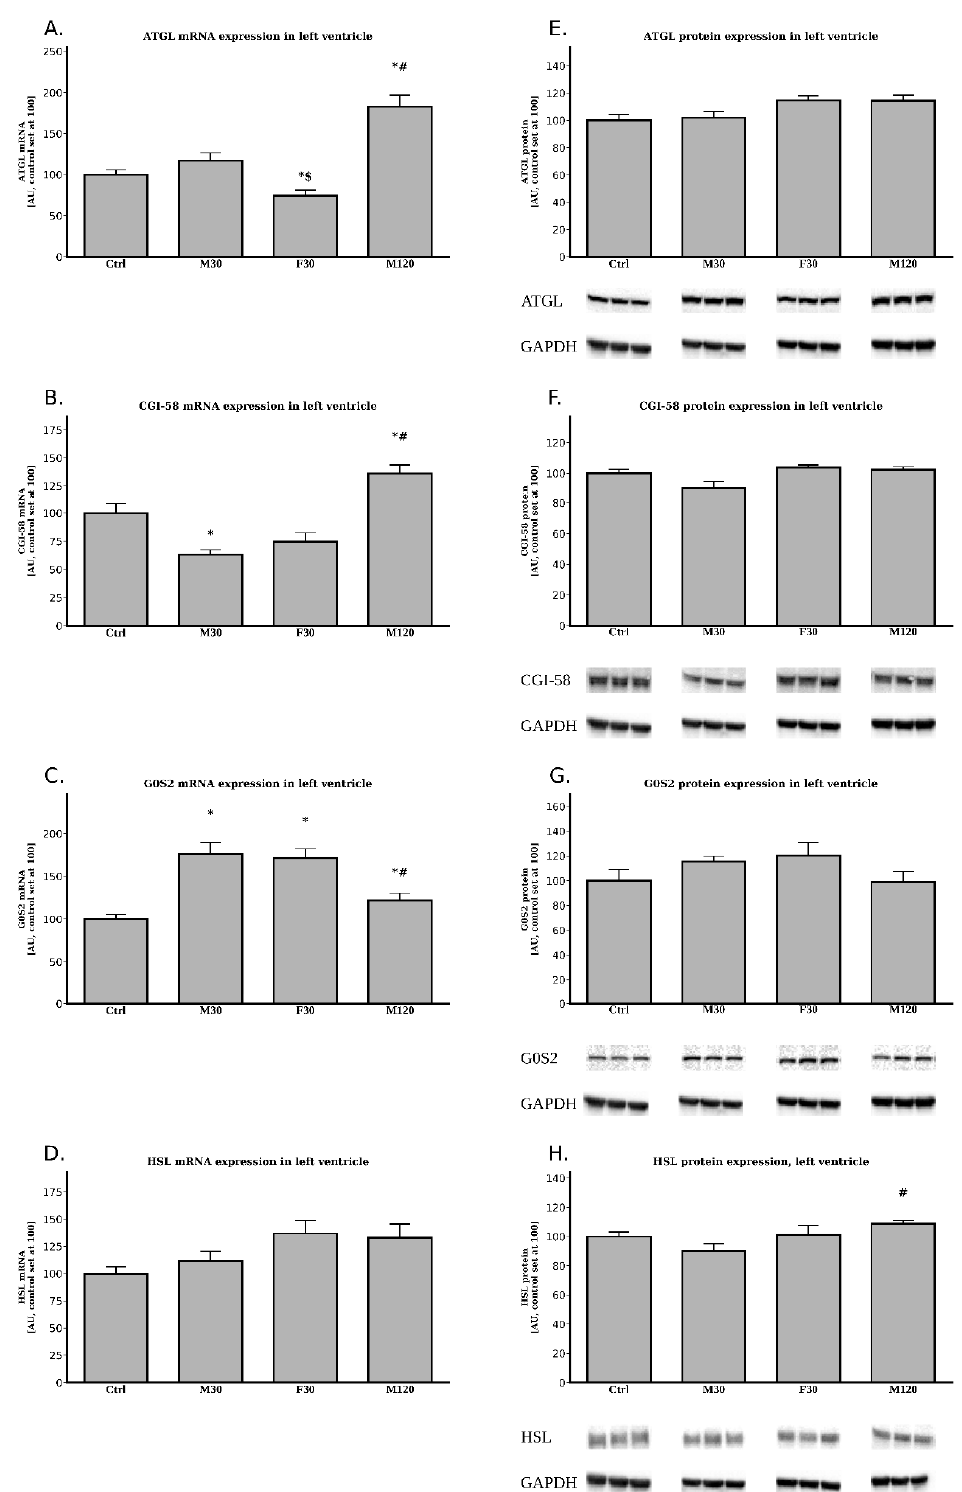
Figure 1. Effects of treadmill running on the mRNA and protein expressions of ATGL ( A , E ), CGI-58 ( B , F ), G0S2 ( C , G ), HSL ( D , H ) in the left ventricle. Data are expressed as mean ± SEM. For the sake of clarity, the control group was set at 100, and exercised groups were scaled with respect to Ctrl * p < 0.05 di ff erence vs. control (Ctrl); # p < 0.05 di ff erence M120 vs. M30; $ p < 0.05 di ff erence F30 vs. M30. Adipose triglyceride lipase (ATGL), comparative gene identification-58 (CGI-58), G0 / G1 switch gene 2 (G0S2), hormone sensitive lipase